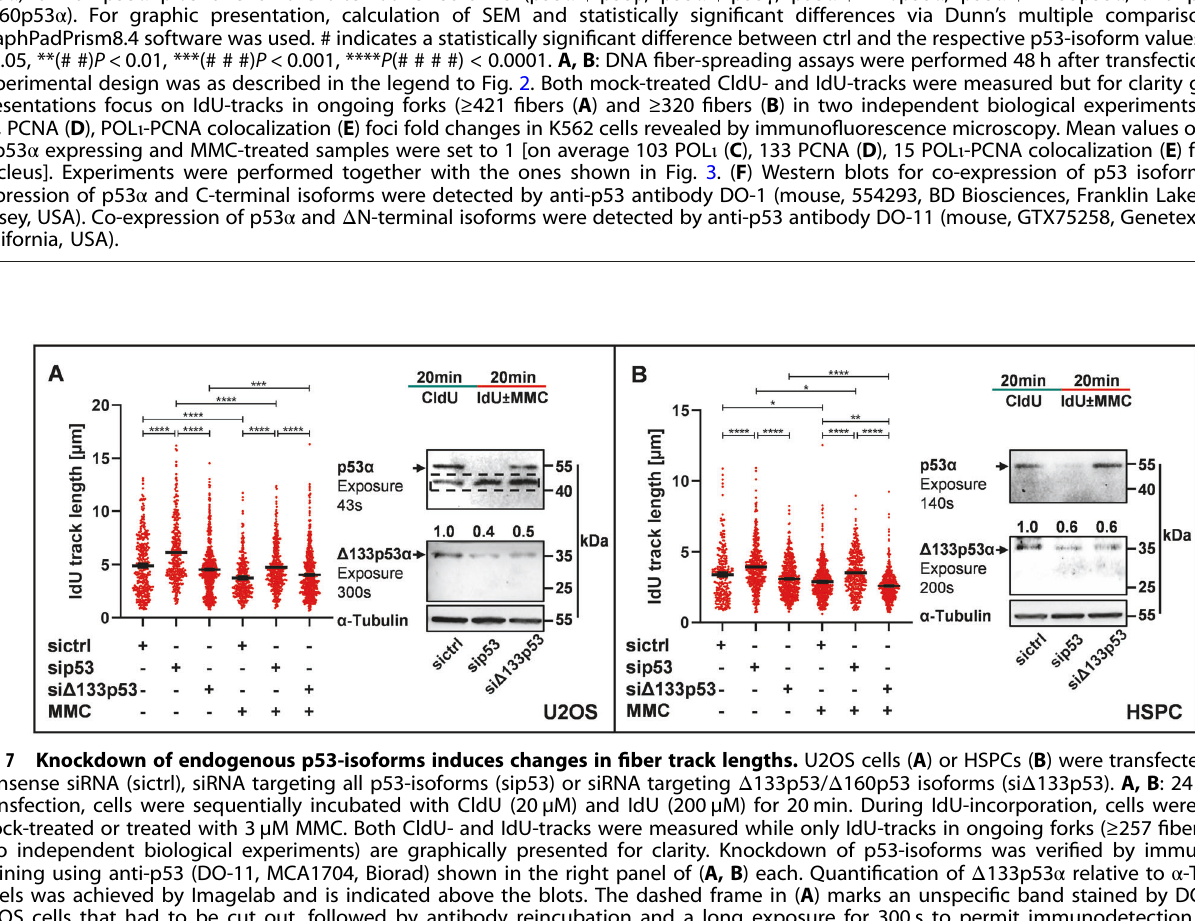
Fig. 6 Co-expression of p53 isoforms affects the POL ι -dependent DDT pathway. K562 cells were transfected with a total amount of 10 μ g plasmid DNA, containing either EV only in controls (ctrl) or expression plasmid for p53 α plus EV (p53 α + EV) or for p53 α plus p53 α (p53 α